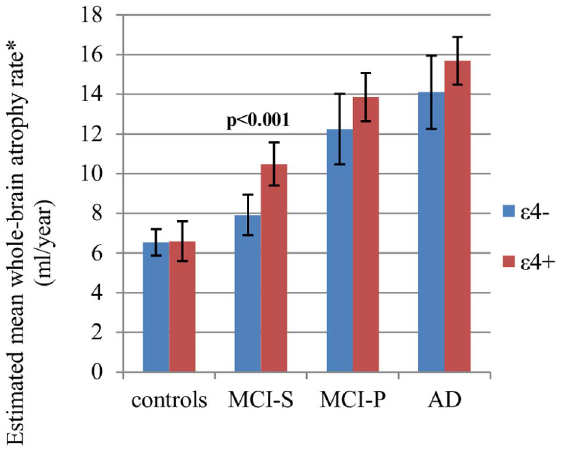
Figure 4. Effect of APOE e 4 on whole-brain atrophy rates.*